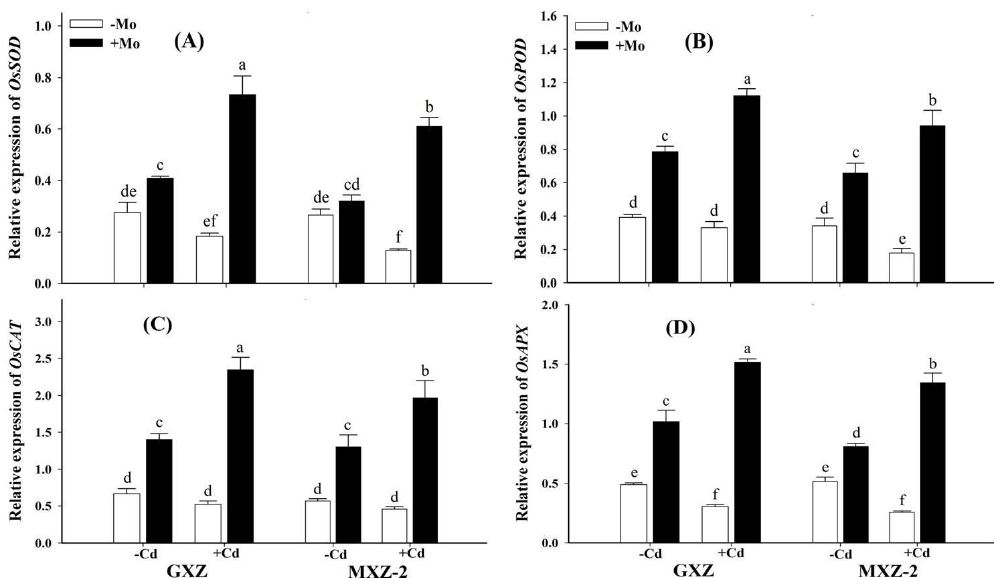
Figure 6. Influence of molybdenum (Mo) and cadmium (Cd) on qRT-PCR analysis of antioxidant enzyme-related transcripts of; ( A ) superoxide dismutase (SOD), ( B ) peroxidase (POD), ( C ) catalase (CAT), and ( D ) ascorbate peroxidase (APX) in leaves of two fragrant rice Guixiangzhan (GXZ) and Meixiangzhan-2 (MXZ-2) cultivars. Both fragrant rice cultivars were treated with two molybdenum levels: 0 µM (–Mo) and 1 µM (+Mo), against two cadmium levels: 0 µM (-Cd) and 100 µM (+Cd) in modified Hoagland solution. Vertical bar above indicates standard error of four replicates. Different lowercase letters (a, b, c, etc.) represent significant differences according to the LSD-test ( p < 0.05, n = 4).